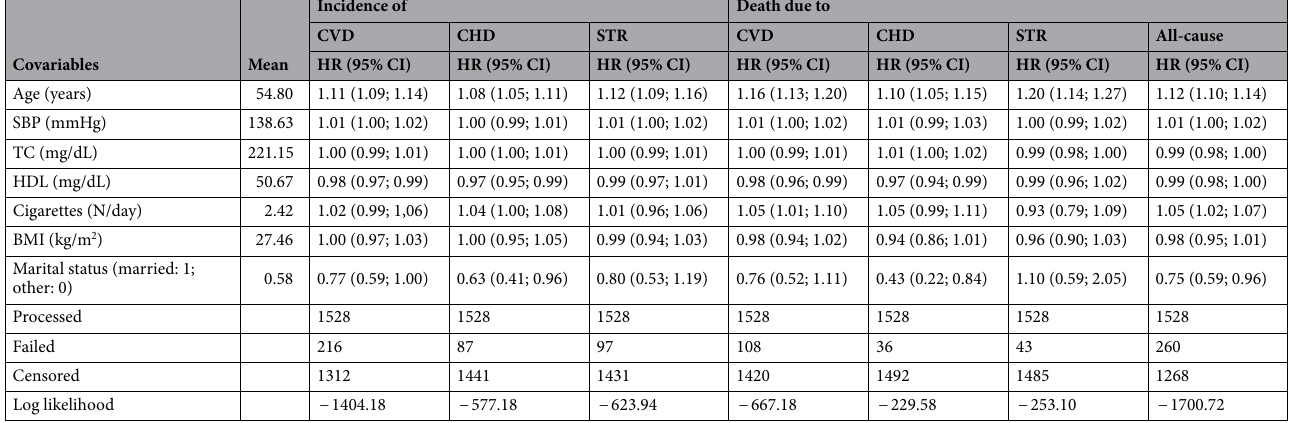
Table 2. Hazard ratios (HR) and 95% confidence intervals (CI) of cox’s model solutions (Efron’s ties method), computed on units of covariates, to study association of many factors with incident events (fatal and non- fatal) or death in all-women of the Gubbio Population Study during 191 months of median follow-up. SBP systolic blood pressure (the average between the second and third measurement), TC total cholesterol, HDL high-density lipoprotein cholesterol, BMI body mass index, CVD cardiovascular disease by hard criteria, CHD coronary heart disease by hard criteria, HR hazard ratio, STR stroke.